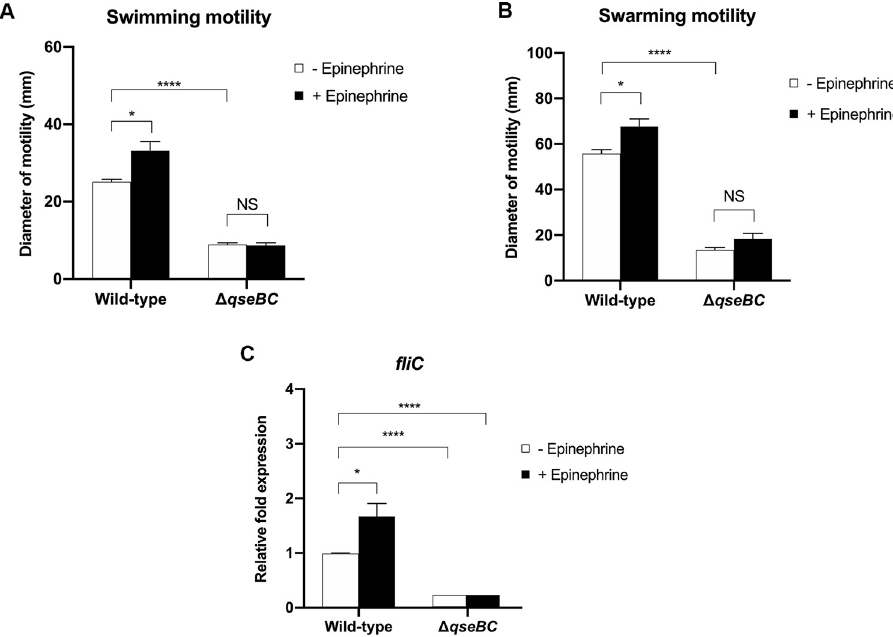
Fig 1. QseBC homologues are required for B . pseudomallei motility. B . pseudomallei wild-type K96243 and Δ qseBC mutant were grown on motility plates in the presence or absence 50 μ M epinephrine. Motility zones after 18 h of incubation were determined. (A) 0.3% (w/v) nutrient agar was used to assess for swimming motility. (B) Swarming motility was assayed using 0.5% (w/v) nutrient agar. (C) Transcription of fliC gene was investigated by real-time reverse transcriptase PCR using B . pseudomallei wild-type K96243 and Δ qseBC mutant cultured to exponential phase in LB medium in the presence or absence 50 μ M epinephrine. Three independent experiments were performed. Error bars represent standard errors of the means following students t -test. Asterisks indicate significant differences ( P � 0.05, t -test).